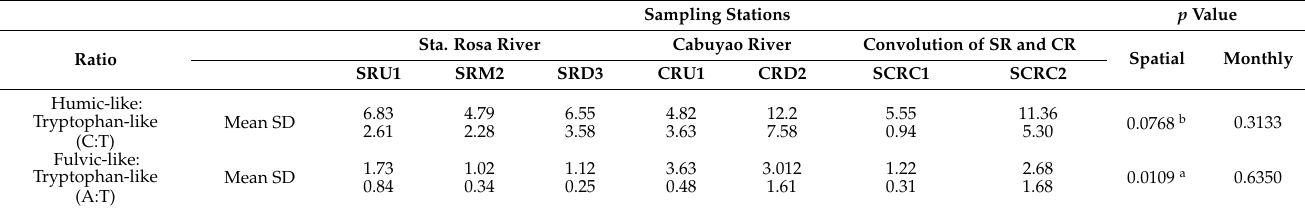
Table 7. Mean fluorescence peak ratio of C: T and A: T in SR and CR. Sampling